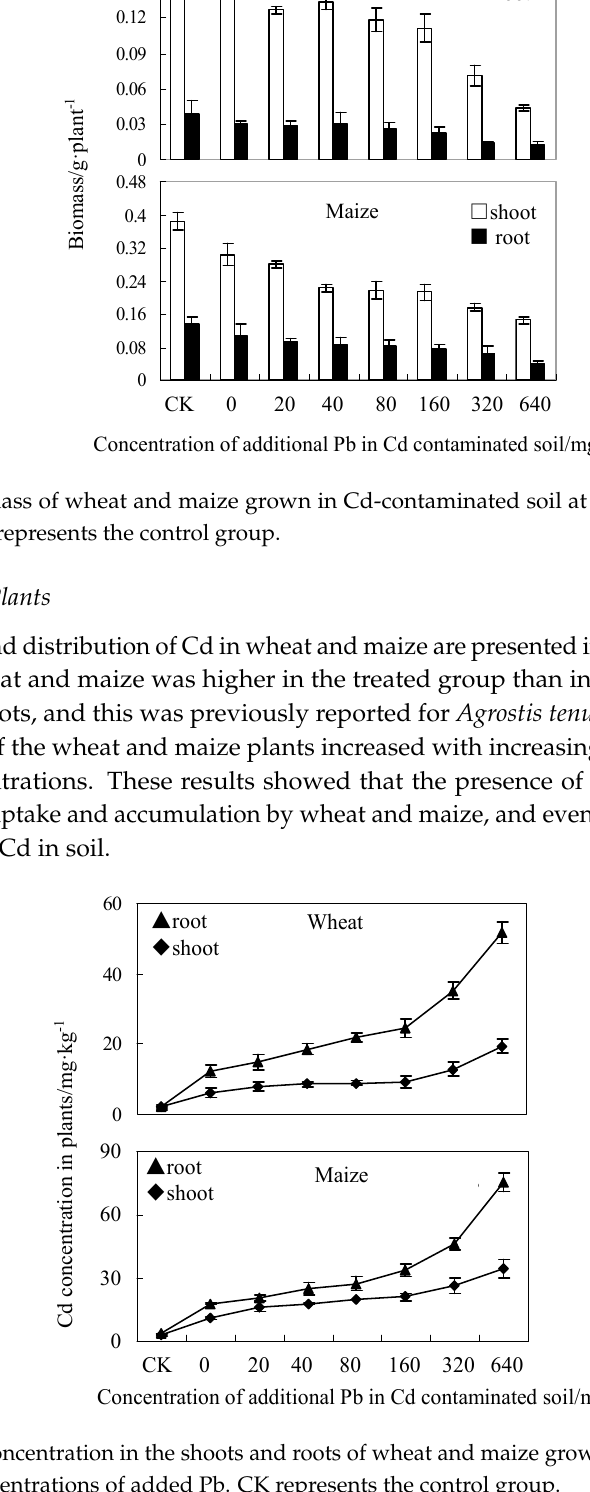
Figure 2. Cd concentration in the shoots and roots of wheat and maize grown in Cd-contaminated soil at various concentrations of added Pb. CK represents the control group.